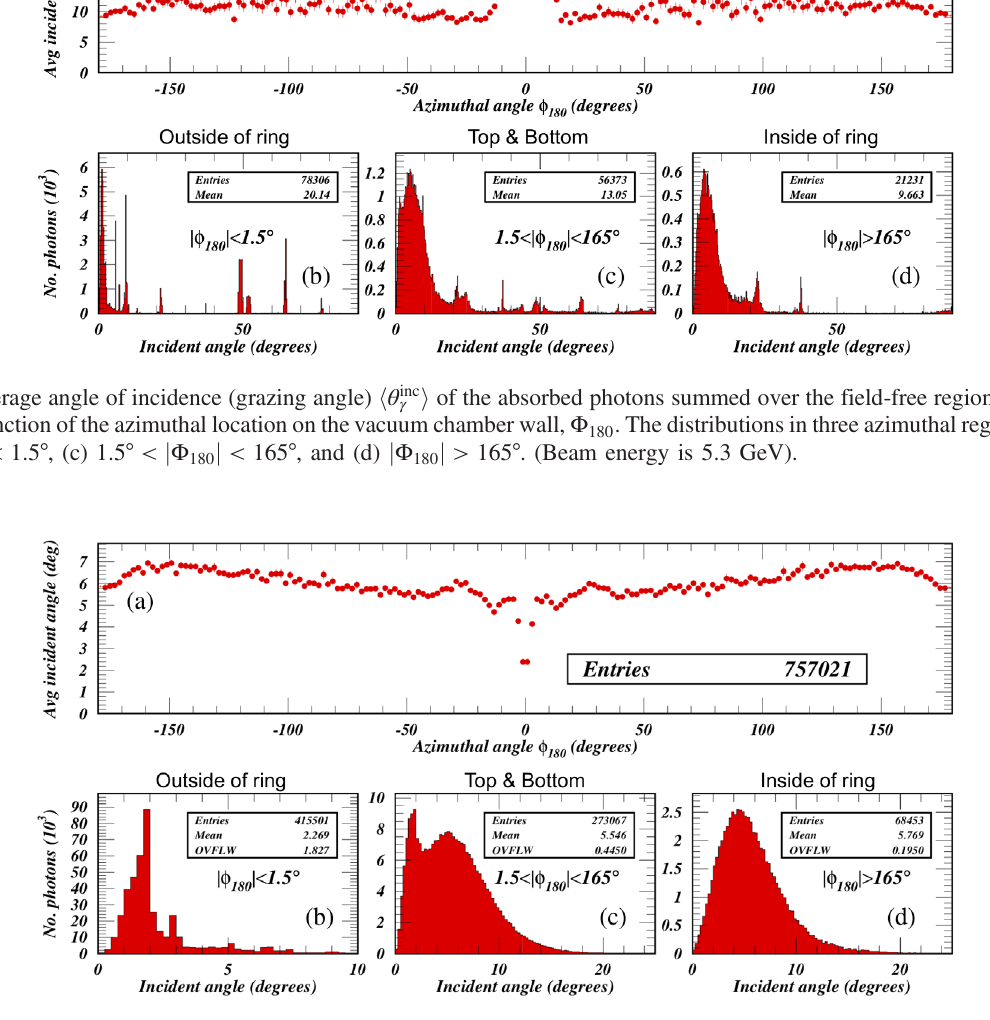
FIG. 13. Average angle of incidence (grazing angle) h θ inc γ i of the absorbed photons summed over the dipole regions of the CESR ring. These distributions can be compared to those summed over the field-free regions of the ring shown in Fig. 12. The dependence of quantum efficiency on incident photon angle results in significantly different photoelectron production rates in the field-free and dipole regions. (Beam energy is 5.3